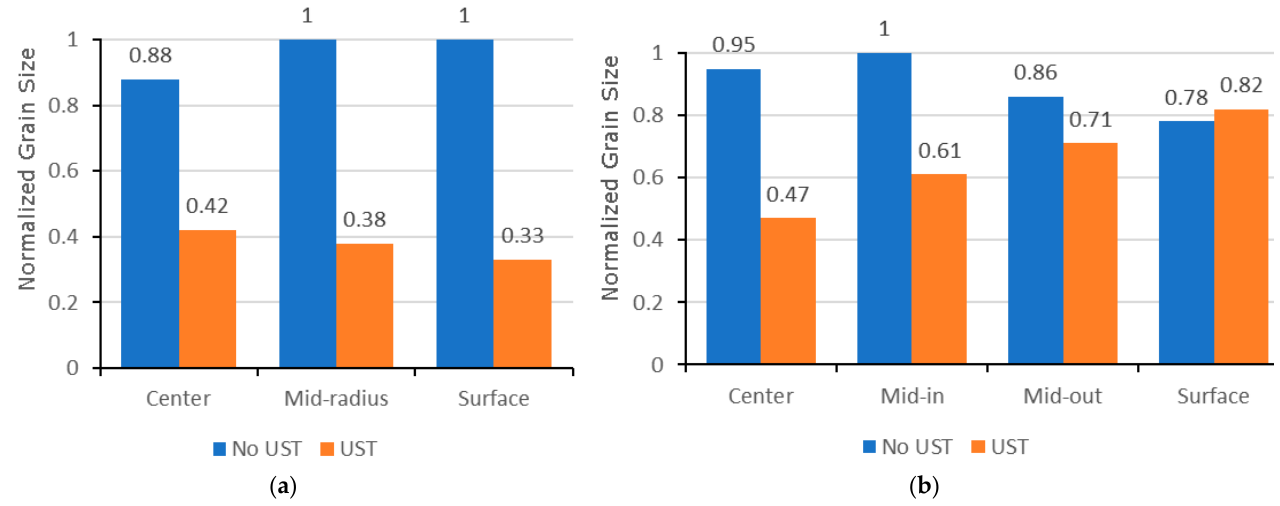
Figure 10. Normalised grain size in experiments before and after processing, for the launder UST (a) and hot-top UST (b) .